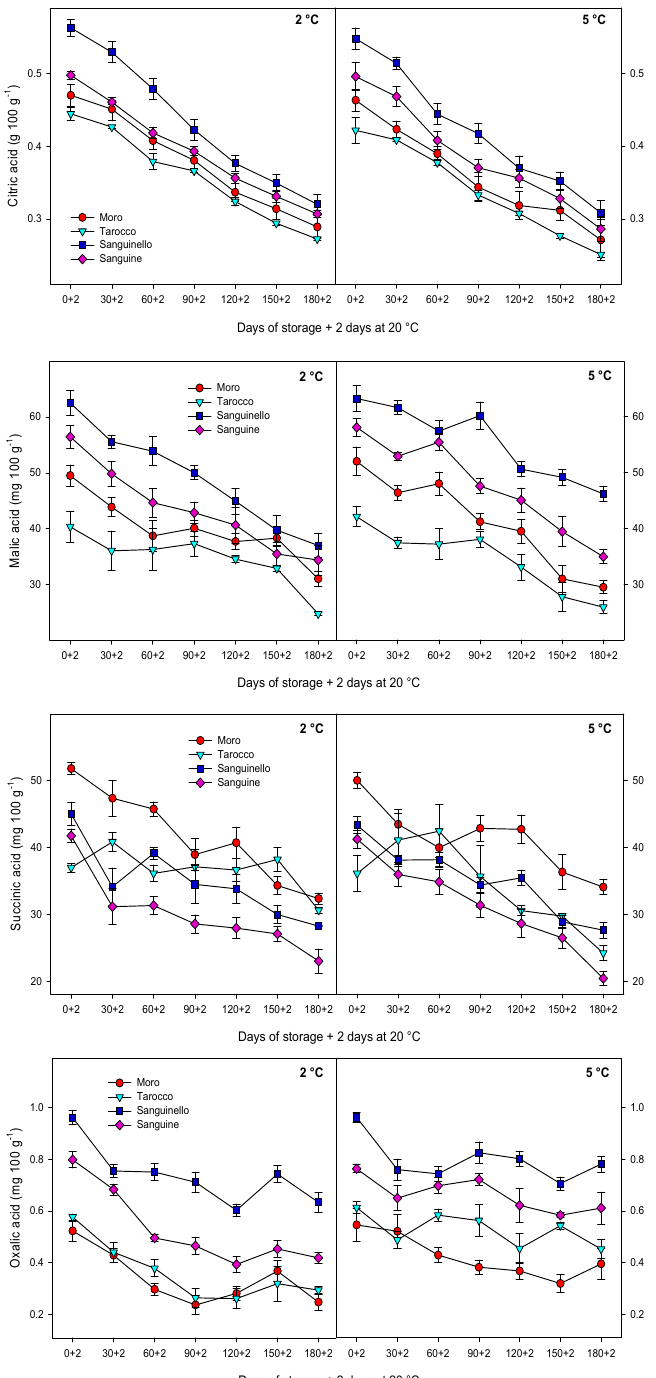
Figure 2. Changes in individual organic acids: citric, malic, succinic, and oxalic acids of blood orange cultivars (“Moro”, “Tarocco”, “Sanguinello”, and “Sanguine”) stored at 2 and 5 °C for 180 days plus 2 days at 20 °C. Vertical bars represent ± standard error (SE) of means. LSD ( p < 0.05) values 0.05, 4.11, 5.98, and 0.09, for citric, malic, succinic, and oxalic acids, respectively.